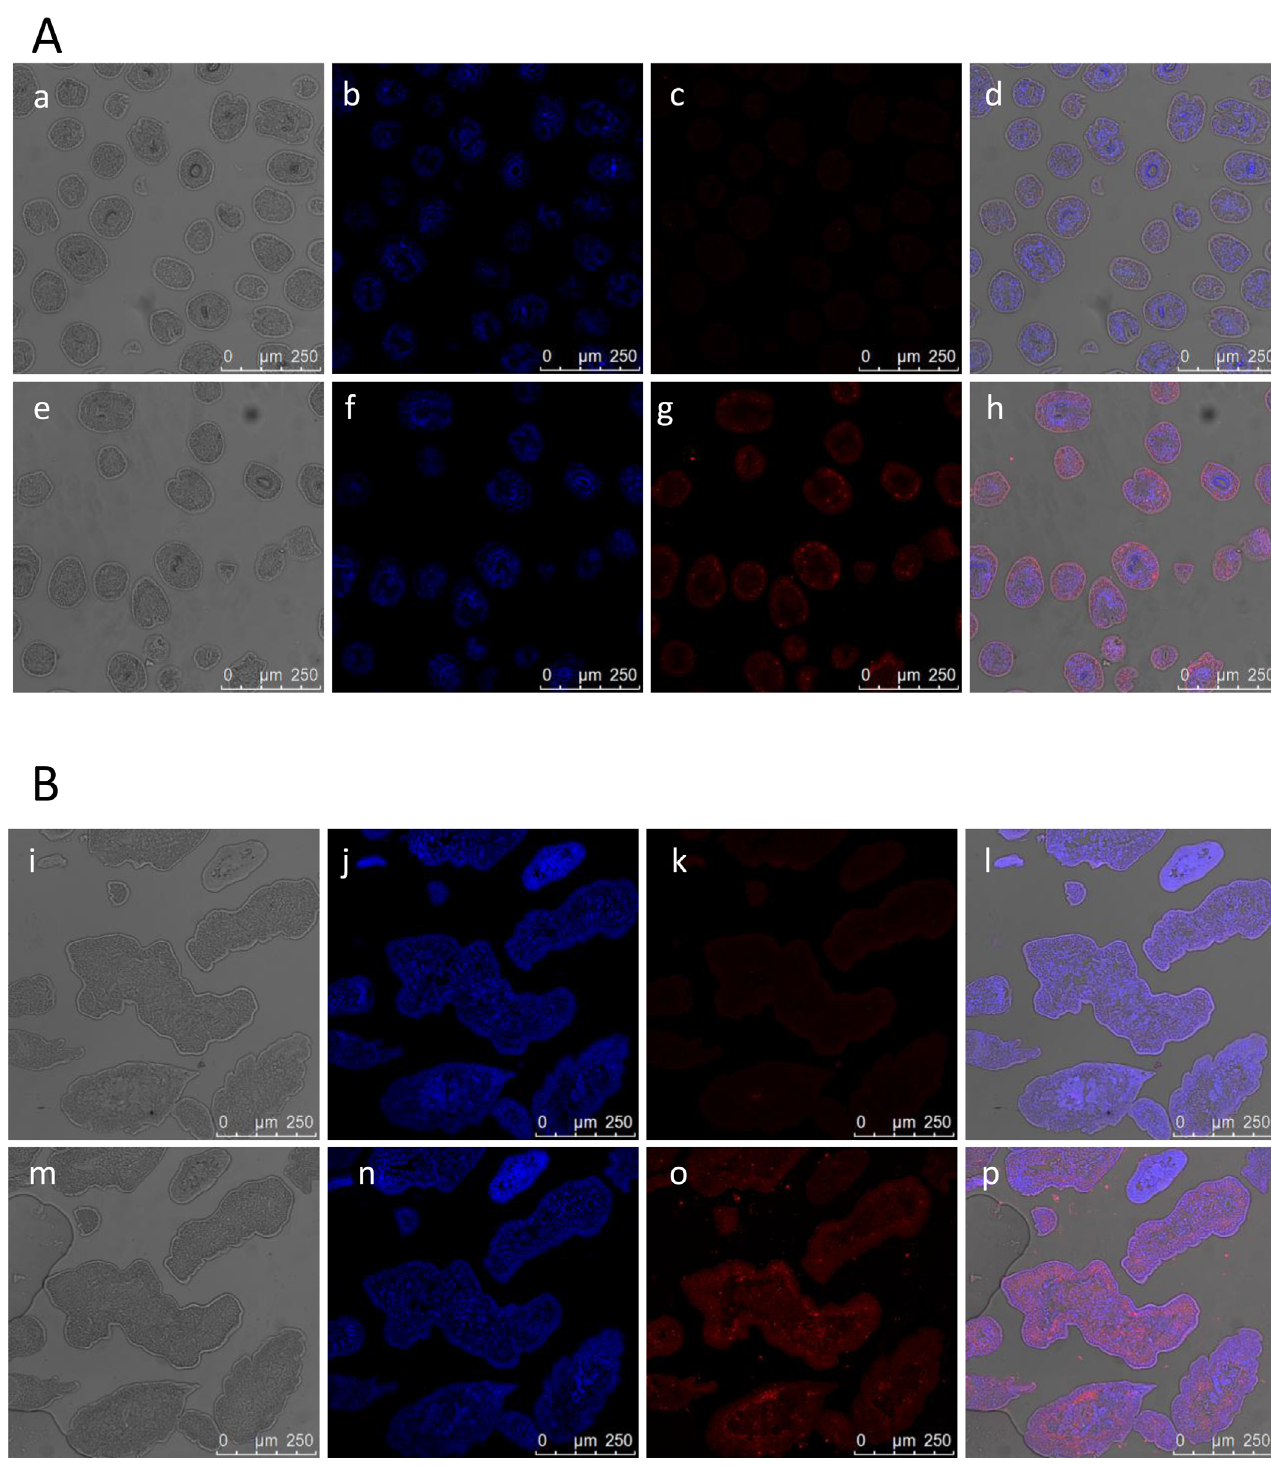
Figure 5. Immunolocalization of EgHR3 in protoscoleces (PSCs) and adult worms of E. granulosus . EgHR3 in PSCs: a and e, showing normal structure of PSC; b and f, stained with DAPI; c and g, probed with normal mouse serum and anti-EgHR3 antiserum, respectively; d and h,combined a, b andc, or e, f and g, respectively, showing co-localization of nucleus andEgHR3 (A). EgHR3 inadult worms of E. granulosus : i and m, showing normal structure of adult worms; j and n, stained with DAPI; k and o, probed with normal mouse serum and anti-EgHR3 antiserum, respectively; l and p, combined i, j and k, or m, n and o, respectively, showing co-localization of nuclei and EgHR3